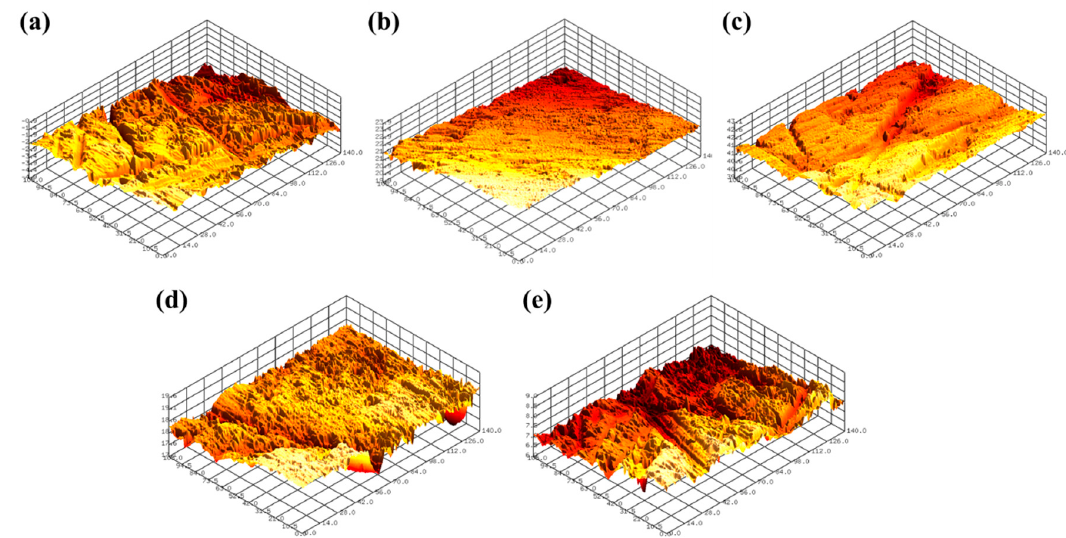
Figure 8. Representative 3D surface profiles of SS304 after FB-CMP with chemical solutions containing various H 2 O 2 concentrations: ( a ) 0 wt % (Sa 0.219 µ m), ( b ) 0.33 wt % (Sa 0.101 µ m), ( c ) 0.67 wt % (Sa 0.185 µ m), ( d ) 1.0 wt % (Sa 0.213 µ m) and ( e ) 1.32 wt % (Sa 0.200 µ m).